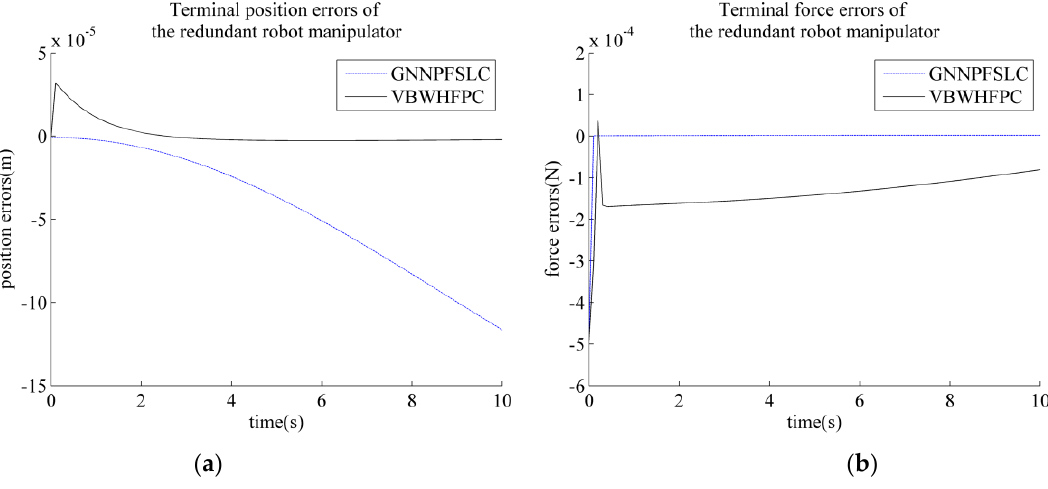
Figure 6. Control accuracy of the above two algorithms in the Y-axis direction ( a ) position control; ( b ) force control.